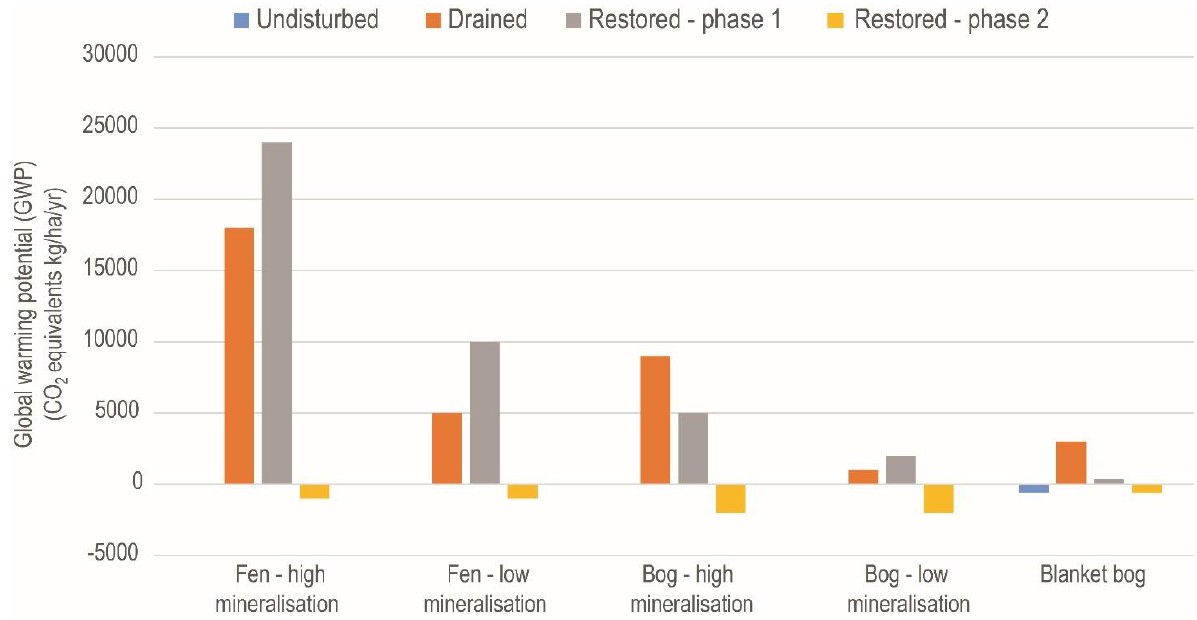
Figure 4. Modelled changes in global warming potential (GWP) of peatlands following restoration (negative numbers represent global cooling). The first three peatland types are adapted from Augustin & Joosten (2007); the blanket bog from Bain et al. (2011), who included additional assumptions about non-gaseous fluxes. Values for the undisturbed state are available for the blanket bog, but not for the other three